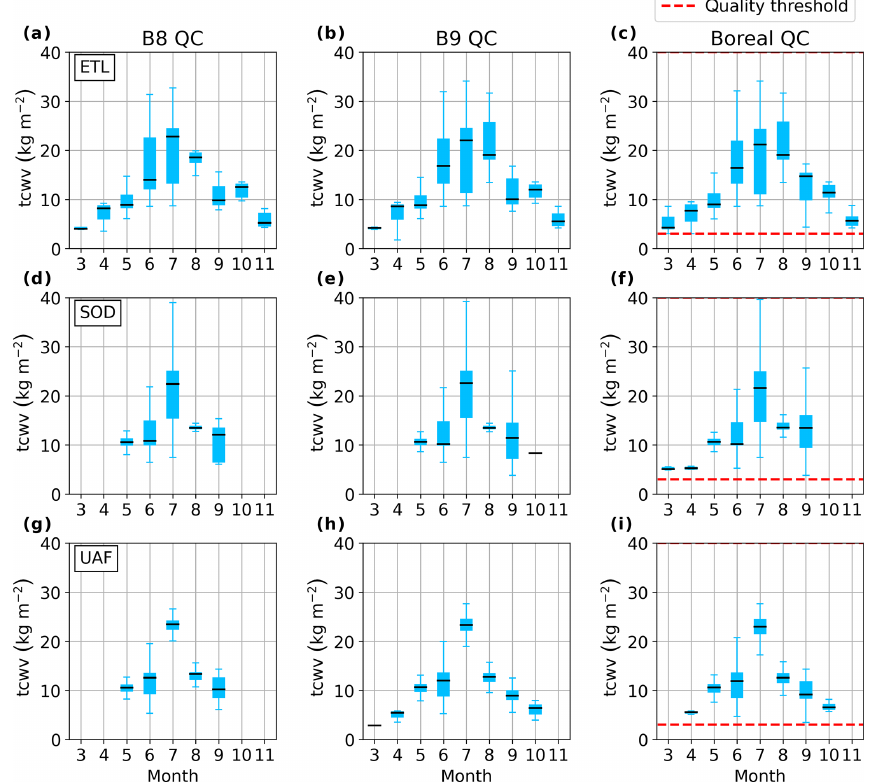
Figure 19. Seasonal box plots of retrieved tcwv (total column water vapor) at (a, b, and c) East Trout Lake, (d, e, and f) Sodankylä, and (g, h, and i) Fairbanks, given each of the three quality control